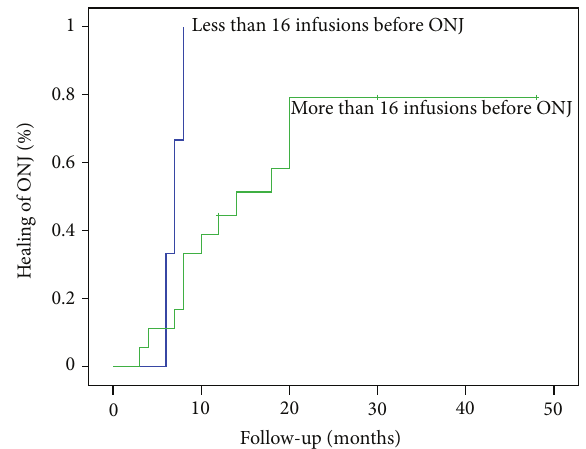
Figure 1: Median time to healing in association with the number of infusions of